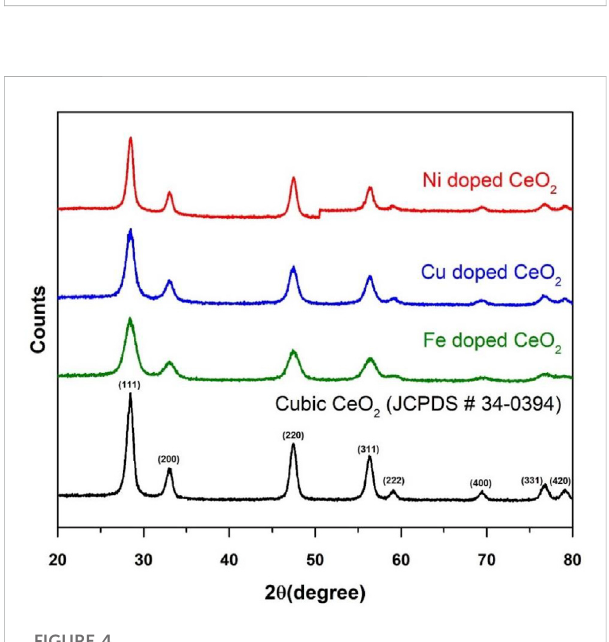
FIGURE 4 The comparison of XRD patterns of pristine CeO 2 with doped CeO 2